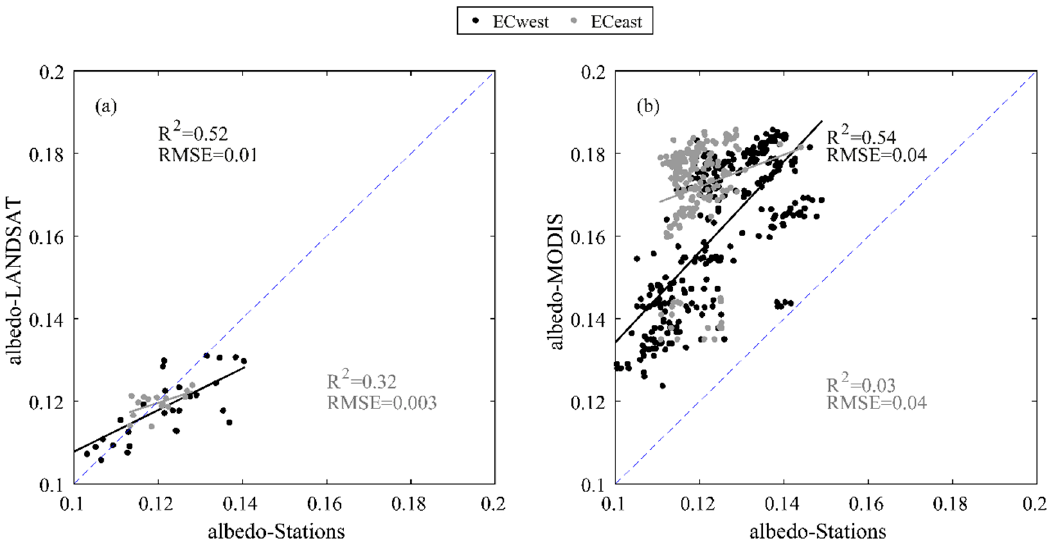
Figure 7. Scatterplot of Landsat albedo ( a ) and MODIS albedo ( b ) versus in situ data.